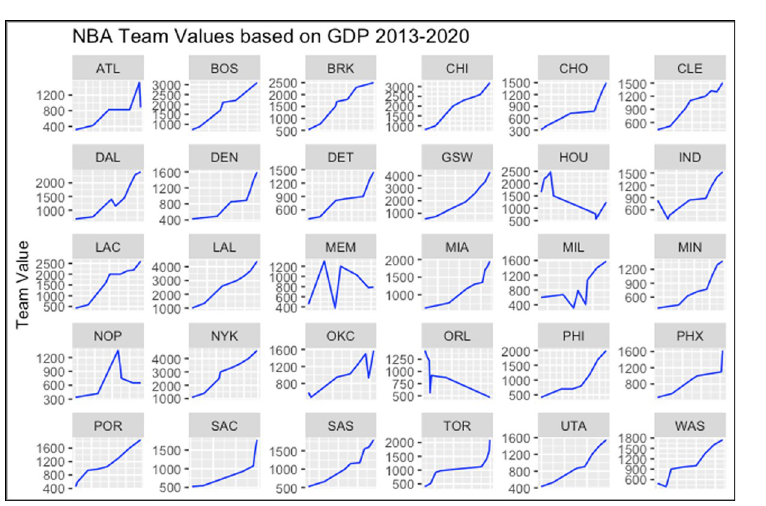
Fig 4. NBA team’s values vs